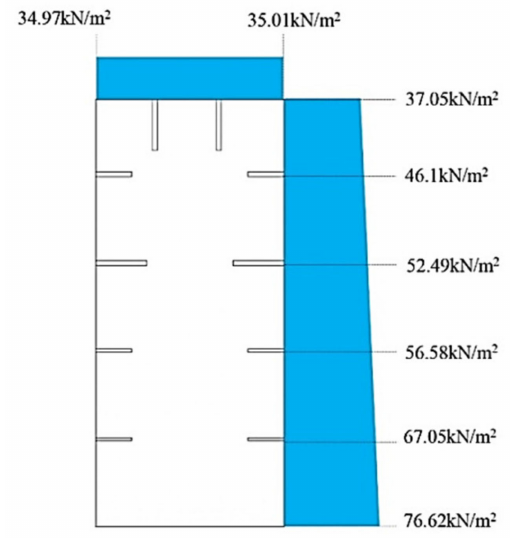
Figure 5. Maximum wave pressure